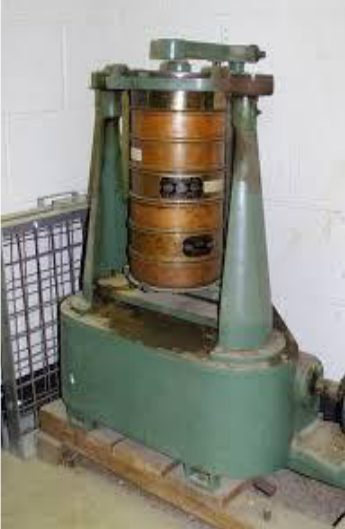
Fig. 2. Sieve analysis system.